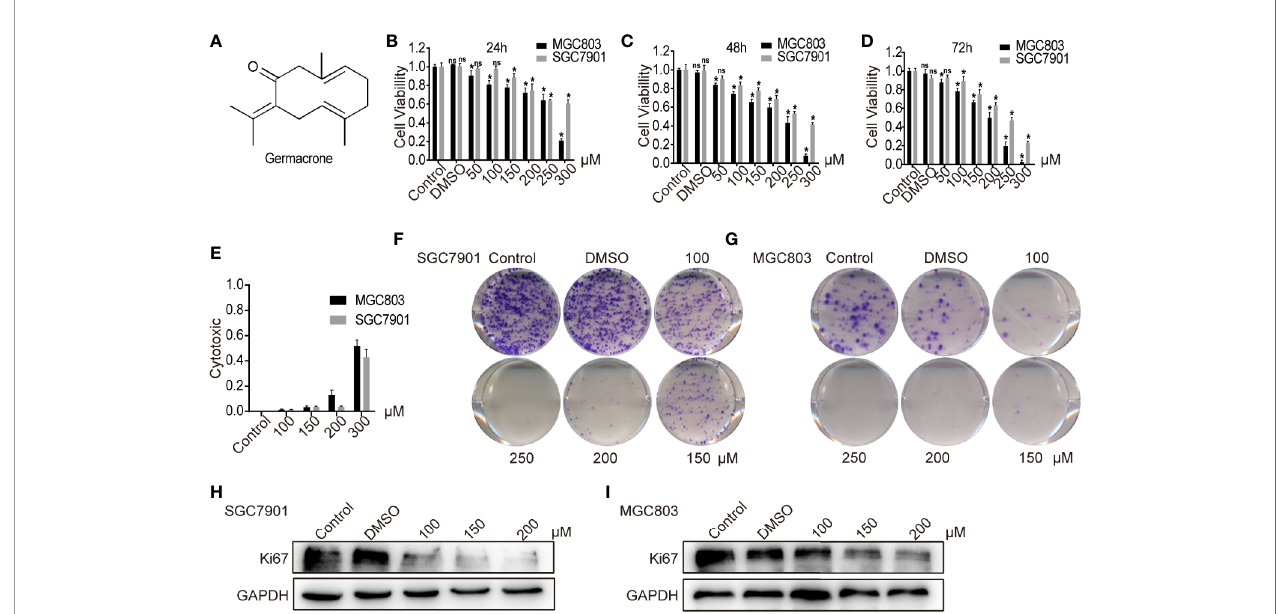
FIGURE 1 | Germacrone inhibited the proliferation of gastric cancer cells in a dose-dependent manner. (A) The structural formula of germacrone. (B – D) The MTT assay assessing changes in cell viability after 24, 48, and 72 h of germacrone treatment (0, 50, 100, 150, 200, 250, and 300 µM). (E) Detection of lactate dehydrogenase (LDH) 24 h after germacrone treatment to evaluate its cytotoxicity. (F, G) Colony formation assay after 24 h of germacrone treatment (100, 150, and 200 µM). (H, I) Western blot analysis of KI67 protein expression. Data are the means ± SD of 3 experiments. * P < 0.05; ns, not signi fi